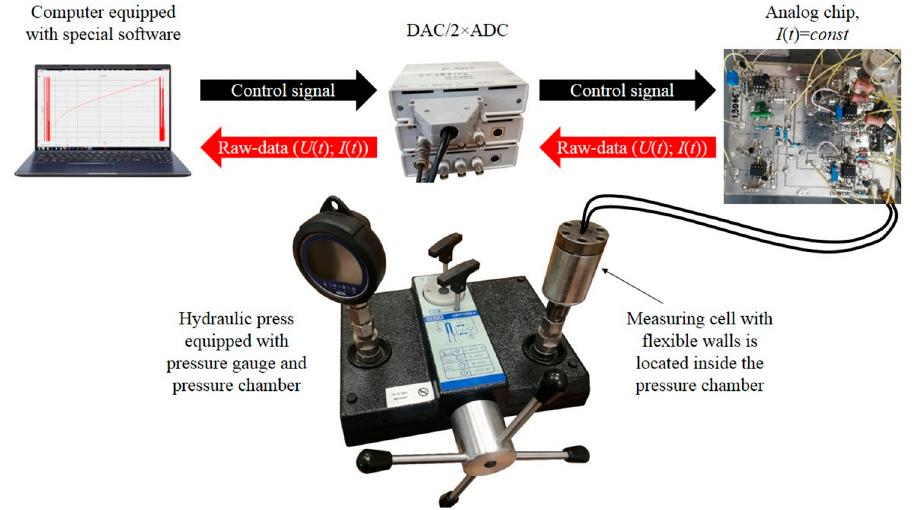
Figure 2. Block diagram of the experimental setup.